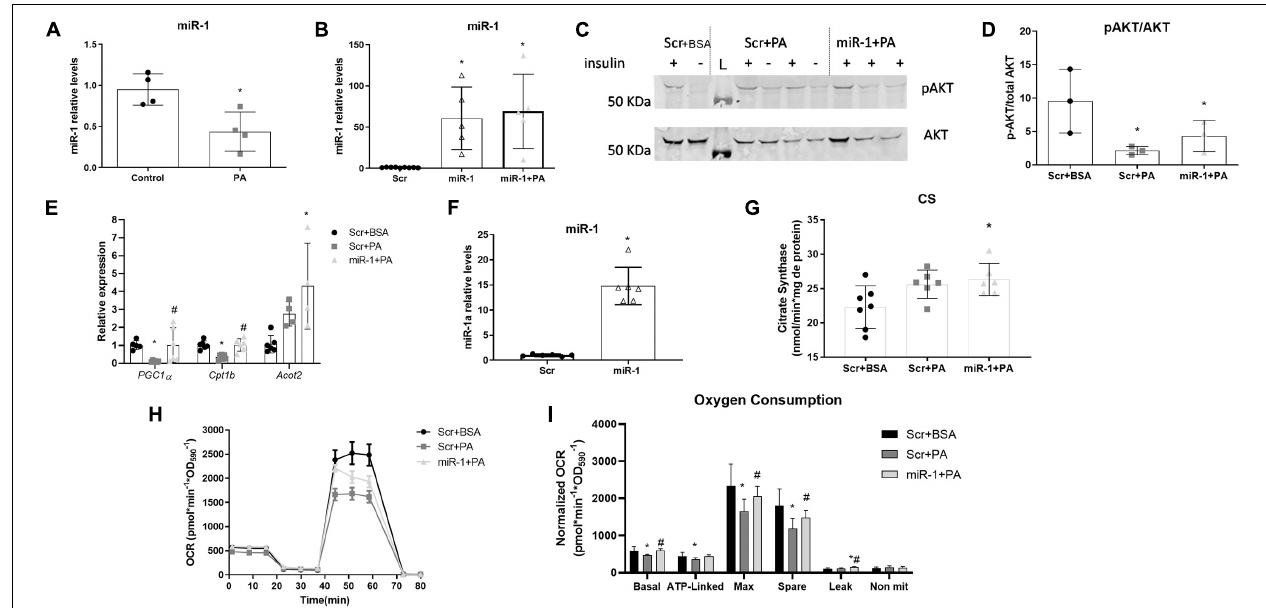
FIGURE 3 | Overexpression of miR-1 protects PA-treated primary skeletal muscle cells from reducing mitochondrial oxidative capacity. (A) miR-1 levels in PA-treated myotubes ( n = 4), (* p < 0.05 vs. control); (B) overexpression of miR-1 in PA-treated cells ( n = 5), (* p < 0.05 vs. Scr); (C) Representative blots of phospho and total AKT levels after insulin treatment of control (Scr), PA-treated (Scr + PA) and miR-1 overexpressing cells treated with PA ( n = 6), L = protein ladder; (D) phospho and total AKT were normalized by total protein content stained with amido black and p/total AKT ratio was calculated in insulin-stimulated cells ( n = 3) (* p < 0.05 vs. Scr + BSA); (E) mRNA expression of mitochondrial and beta-oxidation markers ( n = 6), (*# p < 0.05: (*) vs. Scr + BSA, (#) vs. Scr + PA); (F) overexpression of miR-1 in primary myotubes ( n = 6) (* p < 0.05 vs. Scr); (G) Citrate synthase activity in primary myotubes ( n = 6), (* p < 0.05 vs. Scr); (H) Oxygen consumption rates (OCR) corrected by non-mitochondrial OCR; (I) Basal, ATP-linked, proton leak (leak), spare capacity (spare) and non-mitochondrial (non-mit) OCR from primary myotubes transfected with miR-1 or scrambled control and treated with palmitic acid or vehicle for 24 h ( n = 6). *# p < 0.05: (*) vs. Scr + BSA (C), (#) vs. Scr +